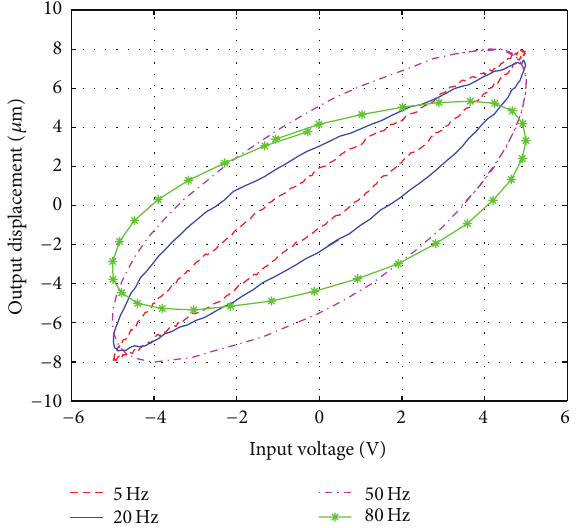
Figure 2: Rate-dependent hysteresis of